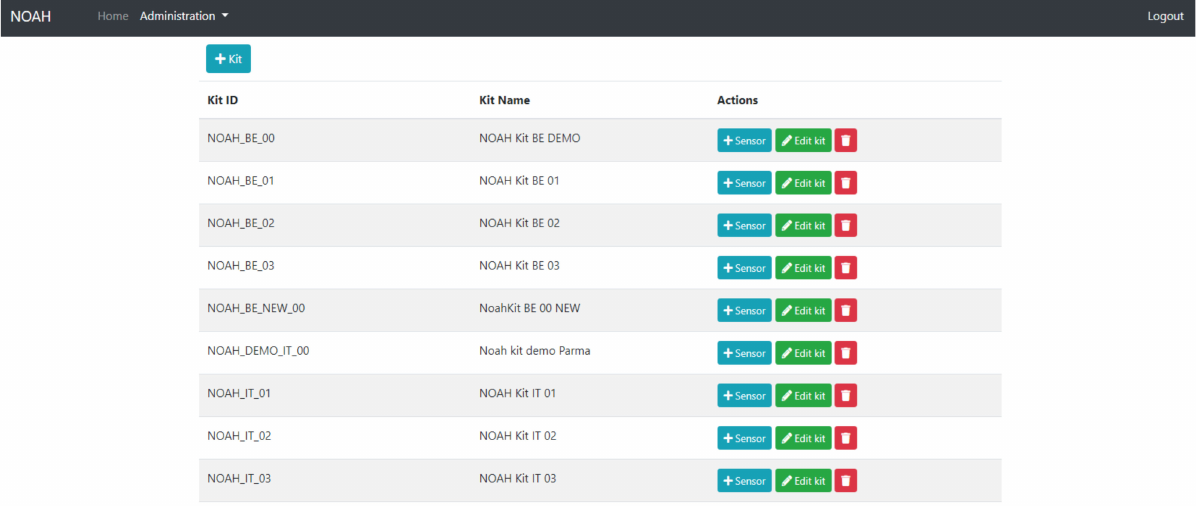
Figure 12. Manage